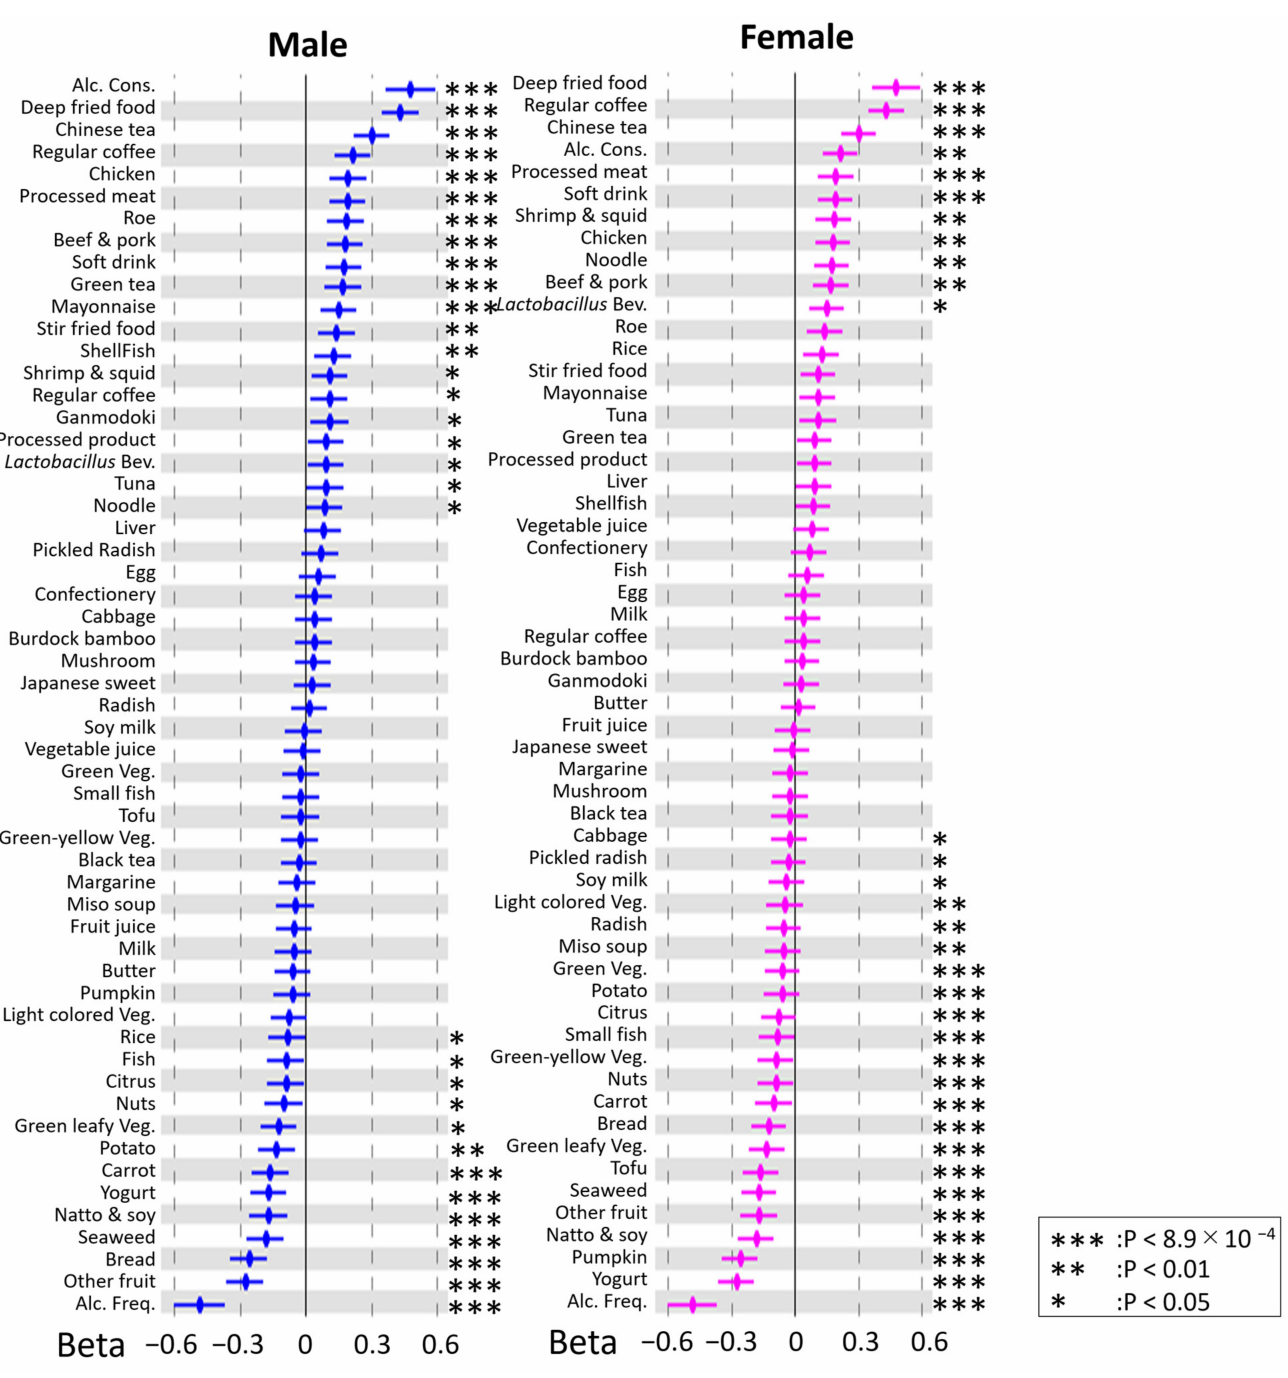
Figure 1. Forest plot showing association between dietary behaviors (DBs) and BMI. The X -axis and Y -axis show the standardized beta coefficient ± standard deviation and each DB, respectively. Blue and pink spots indicate the results for males and females, respectively. Alc. Cons, alcohol consumption; Alc. Freq., alcohol frequency; Lactobacillus Bev., Lactobacillus beverage; Green Veg, green vegetable; Green leafy Veg., green leafy vegetable; Green-yellow Veg, green-yellow vegetable; Light- colored Veg., light-colored vegetable. Asterisks indicate statistical significance (***, p < 8.9 × 10 − 4 ; **, p < 0.01; *, p <